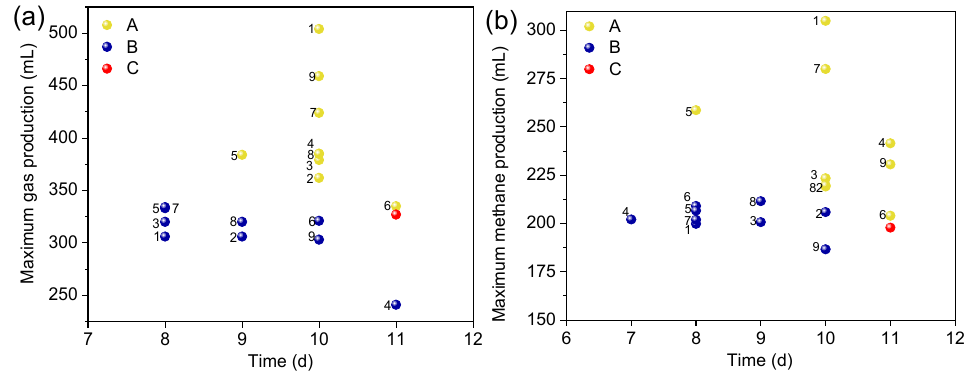
Figure 1. ( a ) Gas production peak period and ( b ) methane production peak using different ABC as supplement.